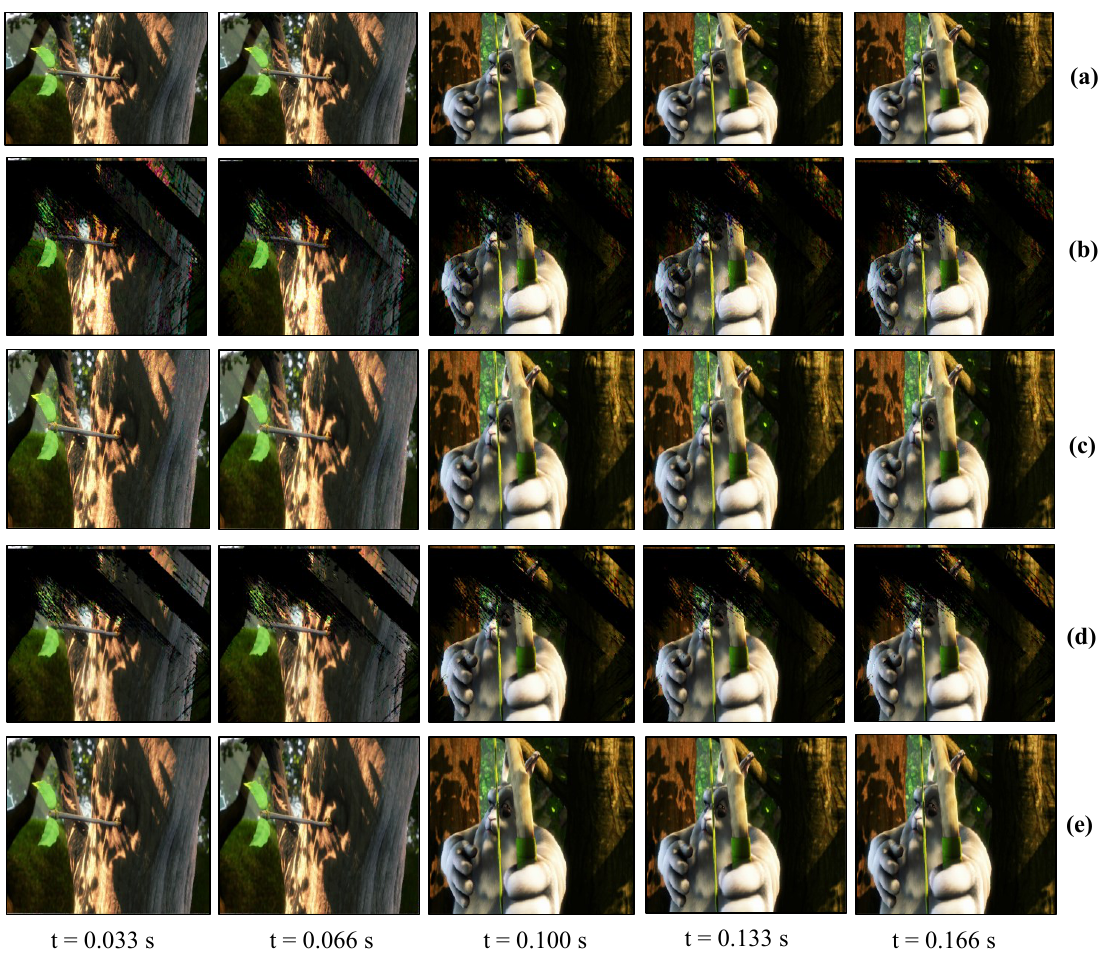
Figure 11. Reconstructed saved image sequence on a patterned background: ( a ) 1920 × 1080 input image; ( b ) 510 × 459 binary-code image without background subtraction; ( c ) 510 × 459 binary-code image with background subtraction; ( d ) 510 × 459 gray-code image without background subtraction; and ( e ) 510 × 459 gray-code image with background